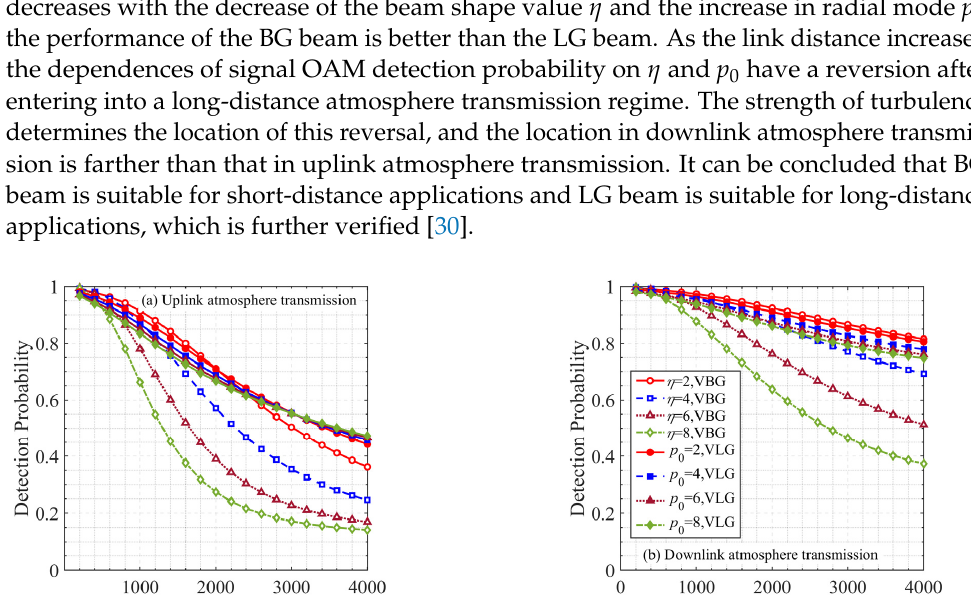
Figure 6. Signal mode detection probability of vector vortex beams versus H with different η or p 0 for uplink ( a ) and downlink ( b ) atmospheric turbulence transmissions. VBG and VLG stand for vec- tor BG beam and vector LG beam, respectively.